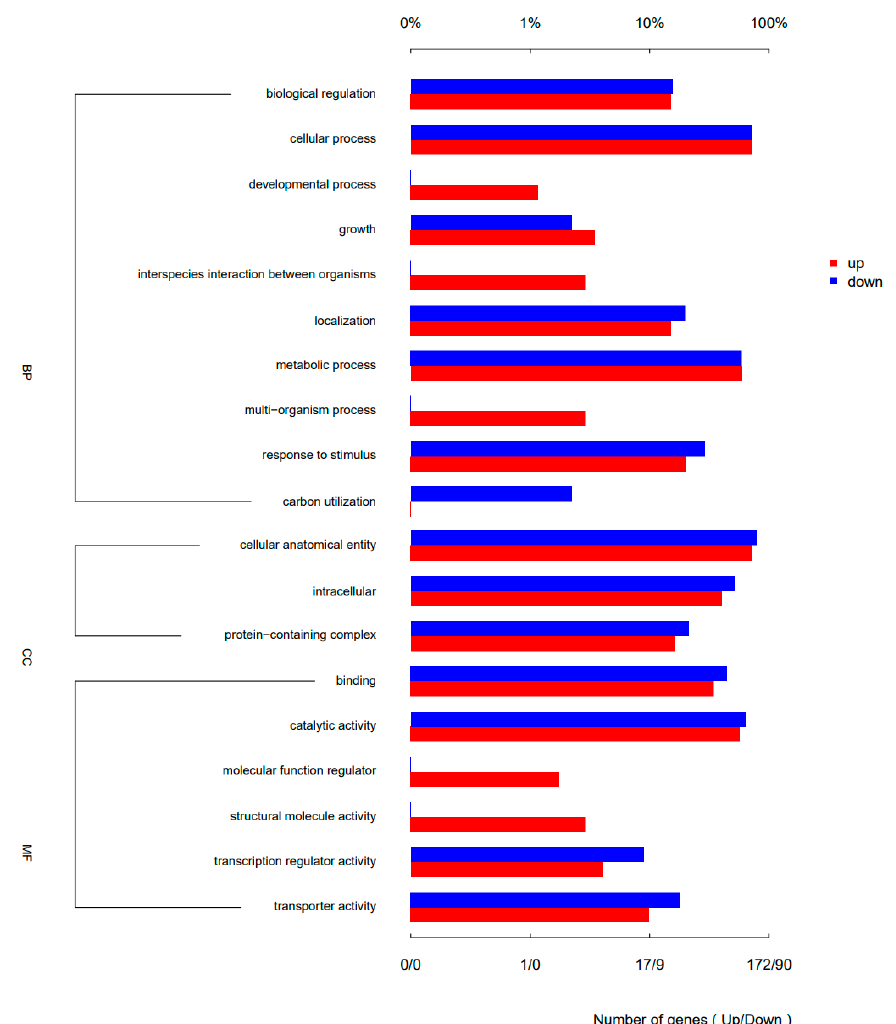
Figure 6. GO secondary annotation map of up- and downregulated di ff erential genes. BP: Biological Process, CC: Cellular Component, MF: Molecular Function.